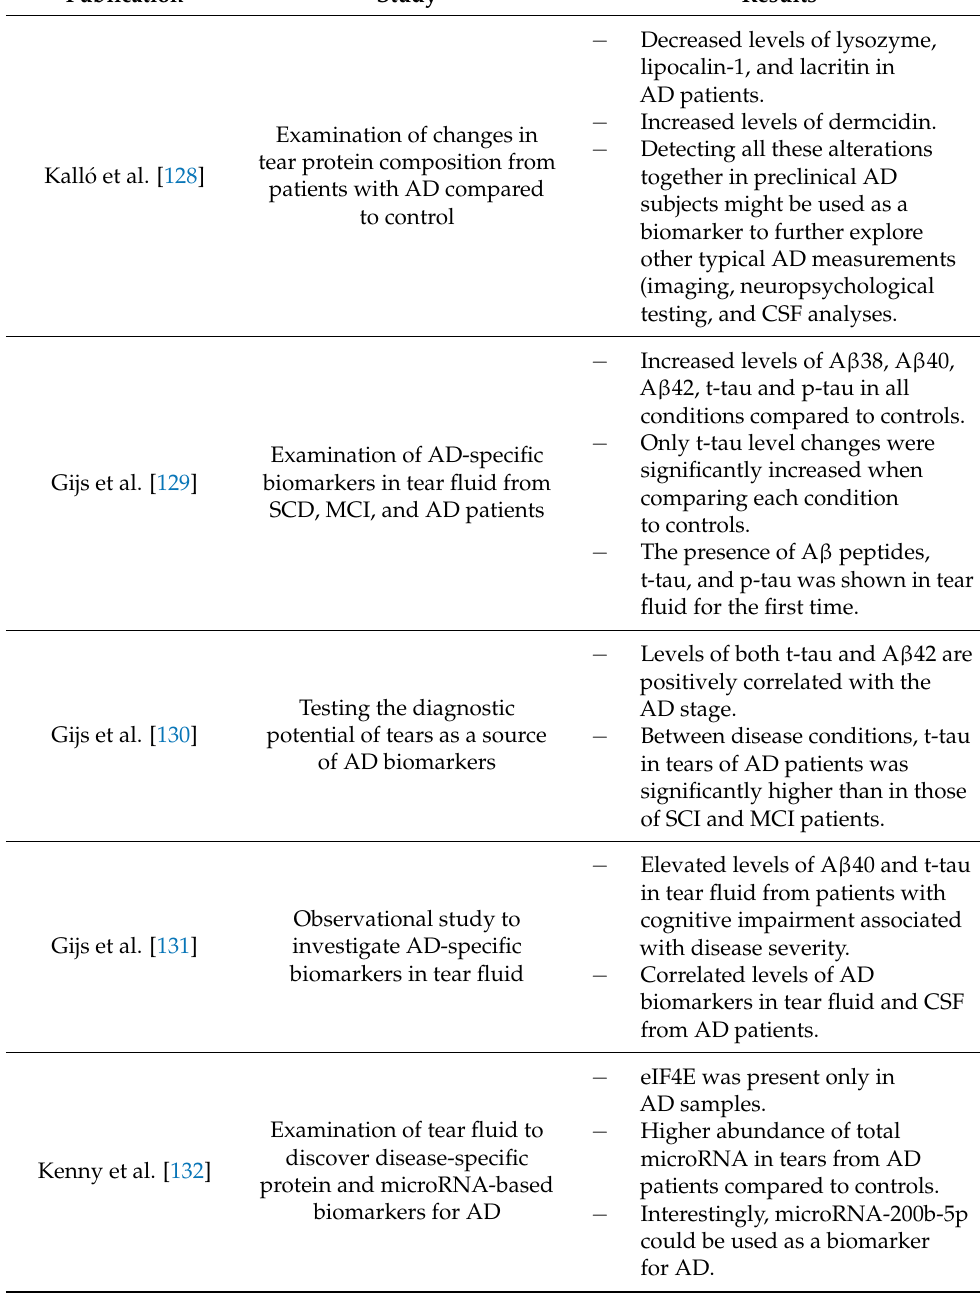
Table 1. Studies observing changes in tear proteomic/molecular